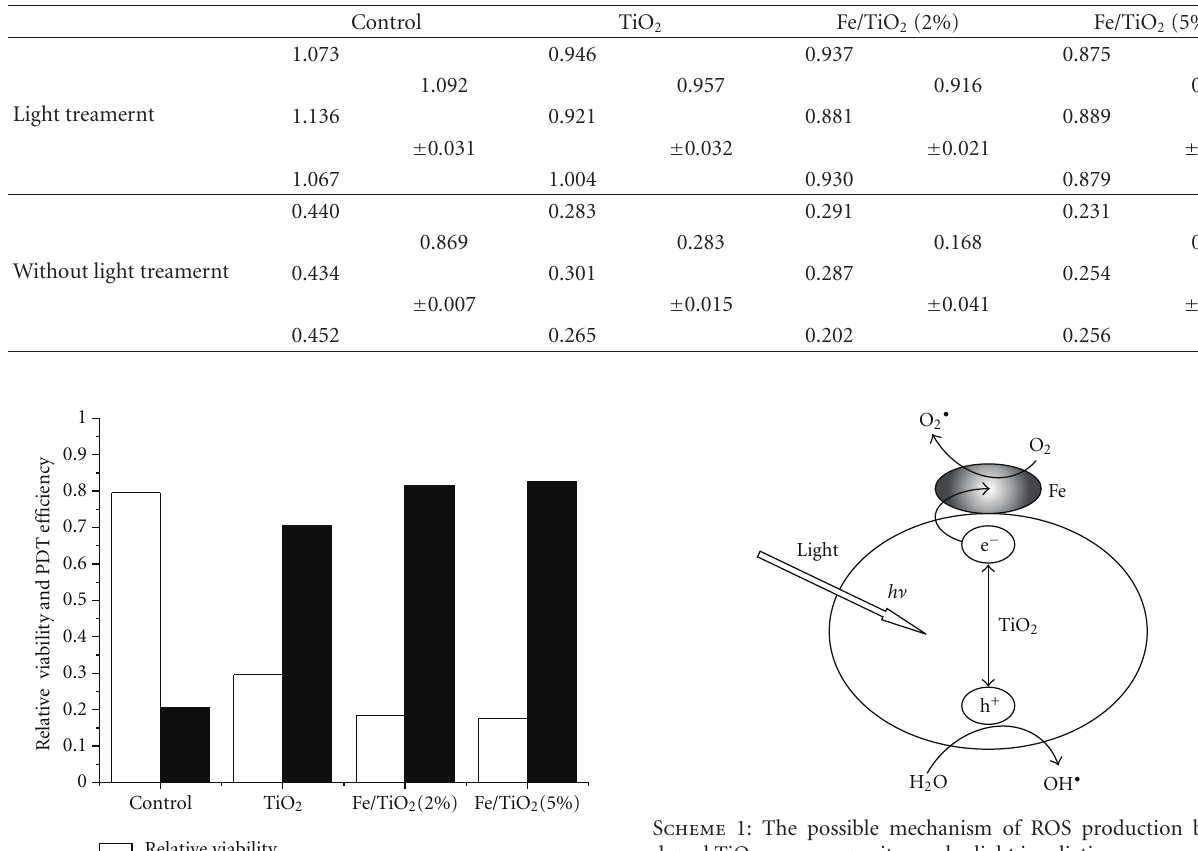
Table 1: The influence of light irradiation on OD values of HL60 cells with di ff erent nanoparticles. Data and the points are presented as the means ± S.D from tree independent measurements. Statistical analysis was then performed and showed that the di ff erences to be significant ( ∗ P < 0 . 05).